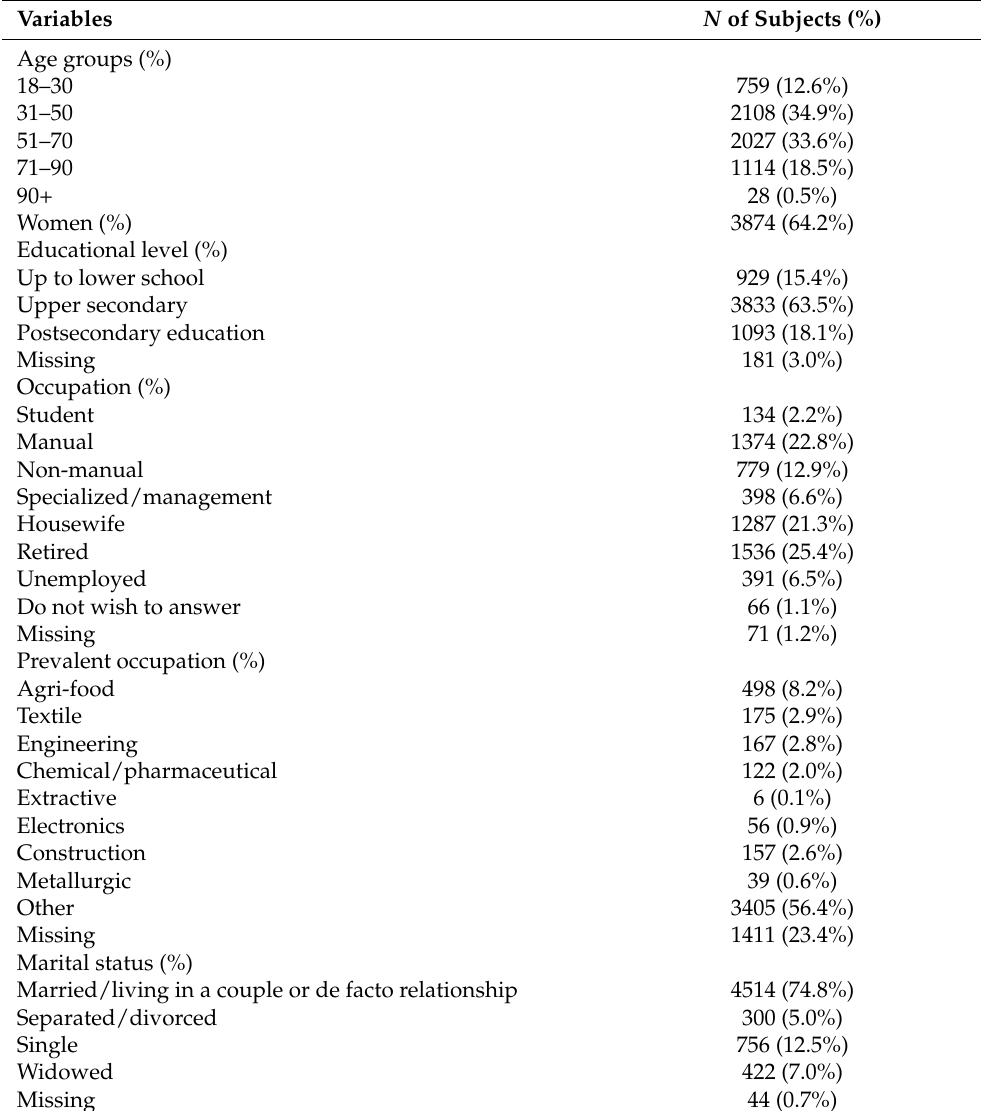
Table 1. Characteristics of the analysed cohort: sociodemographic